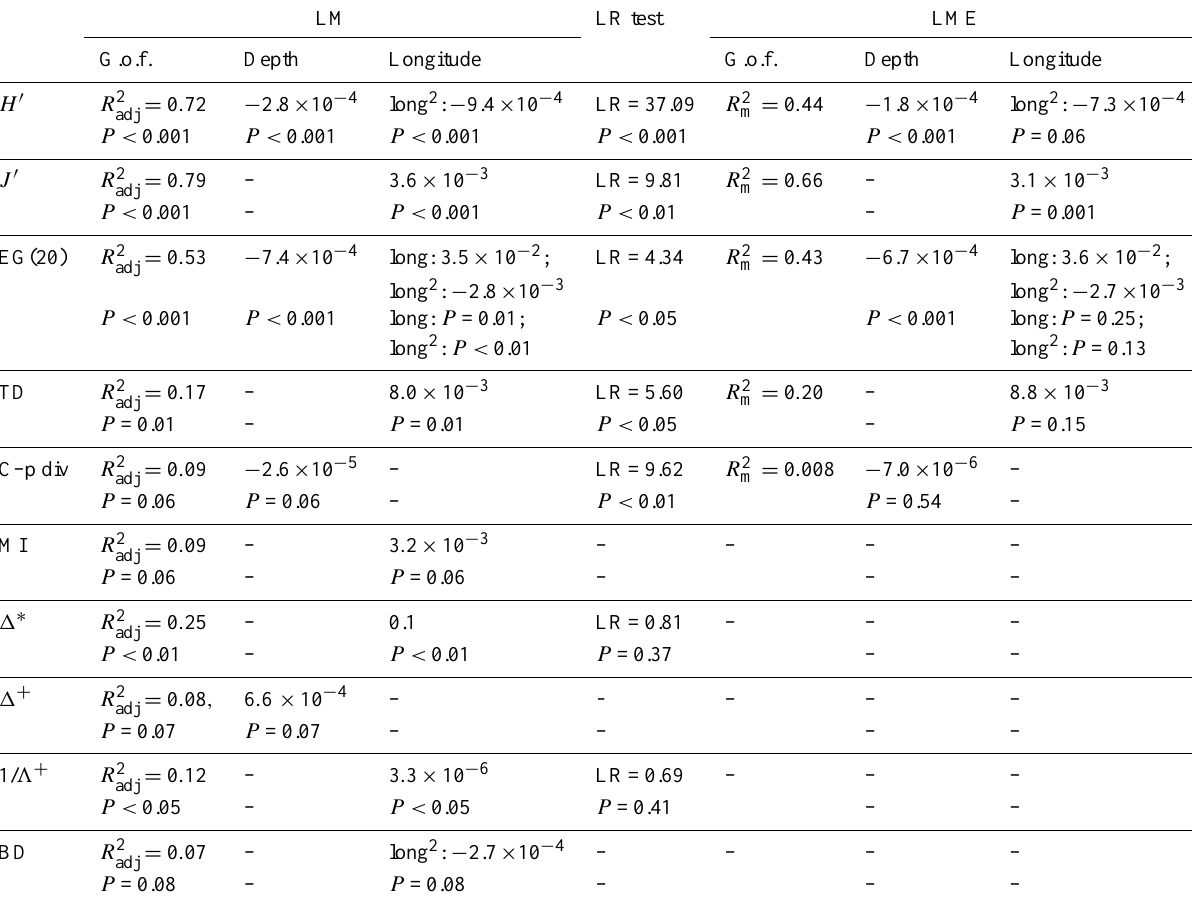
Table 2. Results of linear models (LM), the likelihood ratio (LR) test and the linear mixed-effect models (LME) for the regression of water depth and longitude against nematode diversity. For the independent variables depth and longitude (long), the estimated size of the effect and the associated P value are given. For EG(20) both long and long 2 were retained in the model. For H 0 and BD, long was squared (long 2 ) to comply with regression assumptions. H 0 : Shannon–Wiener diversity, EG(20): expected genus richness for a sample of 20 individuals, J 0 : Pielou’s evenness, TD: trophic diversity, c–p diversity: diversity of c–p (life history) classes, MI: maturity index, 1 + : average taxonomic distinctness based on presence–absence data, 1 ∗ : average taxonomic distinctness based on quantitative data, 1/ 3 + : taxonomic